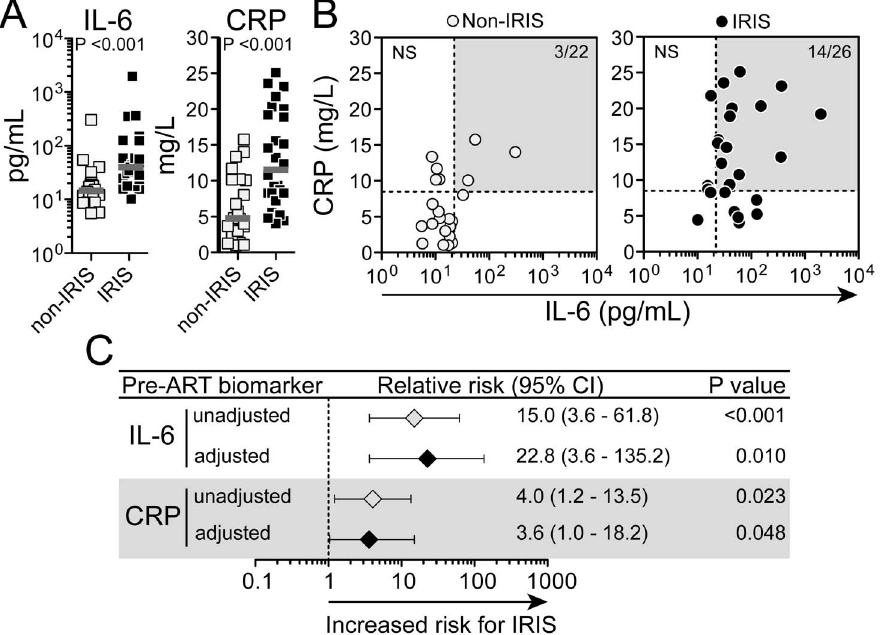
Figure 2. Pre-ART plasma levels of IL-6 or CRP distiguish individuals at higher risk for TB-IRIS. (A) Pre-ART plasma concentrations of IL-6 (left panel) and CRP (right panel) were compared between individuals who developed TB-IRIS during study follow up and those who did not using the Mann-Whitney test. (B) Correlation between IL-6 and CRP values was tested in both groups of patients using the Spearman test. In (B), dotted lines represent the median pre-ART values of IL-6 or CRP in the entire study population. Gray areas highlight those patients displaying values for both biomarkers above their respective median values within the study population. (C) The associations between systemic levels of IL-6 and CRP with risk for subsequent TB-IRIS were assessed by univariate and multivariate models. Relative risks (RR) are per standard deviation increase after log 10 transformation. RR were adjusted for baseline age, gender, weight, hemoglobin, hematocrit, sputum culture grade, presence of extra pulmonary TB, presence of miliary TB, days to ART initiation, plasma HIV RNA levels and CD4 + T-cell count. CI, confidence interval.